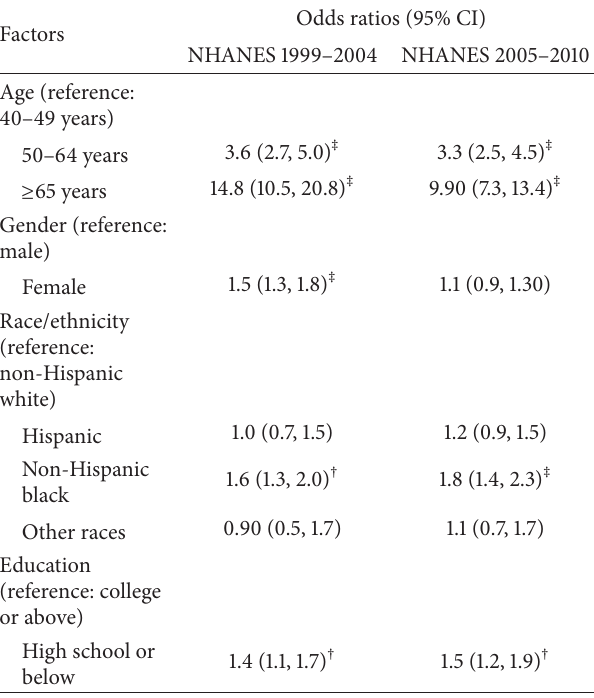
Table 4: Odds ratios and 95% confidence intervals of isolated sys- tolic hypertension by demographic factors in NHANES 1999–2010,